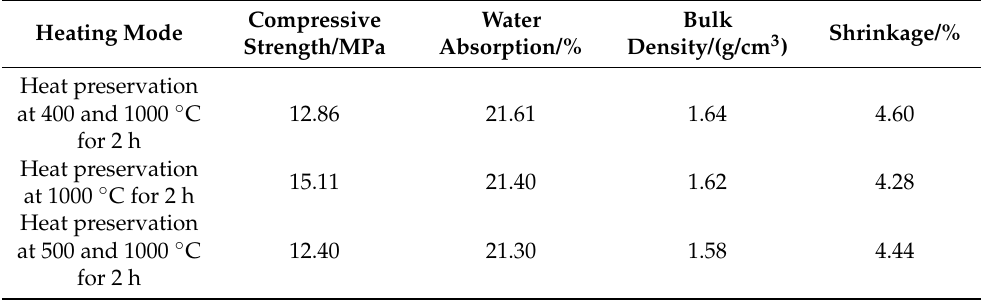
Table 5. Effect of heating mode on properties of sintered bricks.